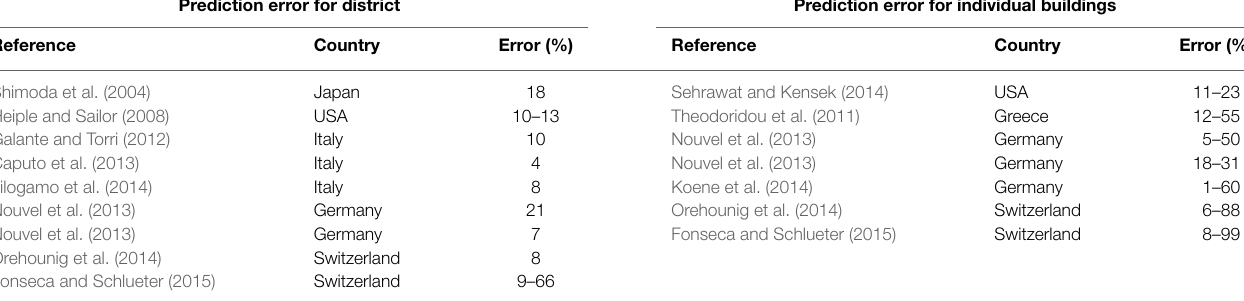
TABLE 2 | Summary of the accuracy level of the previous works . Prediction error for